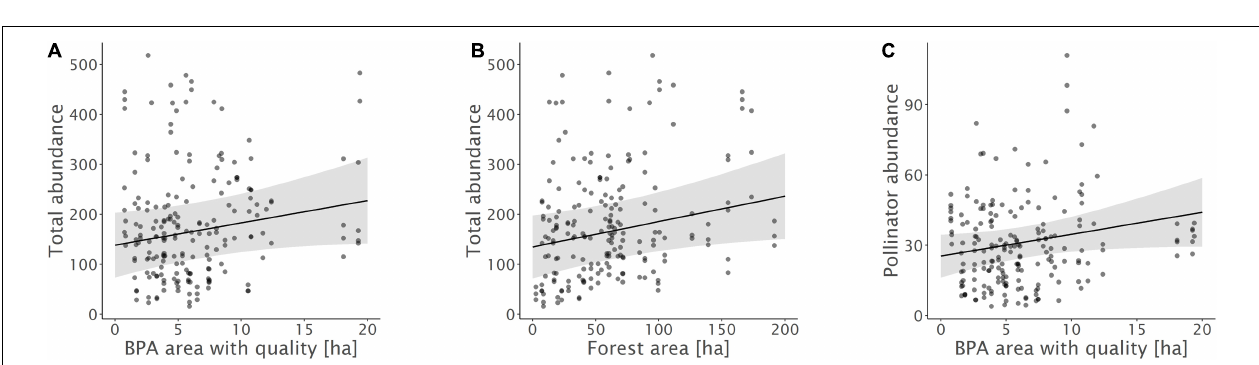
FIGURE 2 | Relationships between (A) total insect abundance, (B) pollinator abundance, (C) natural enemy abundance, (D) wild bee abundance, (E) wild bee species richness, (F) wild bee diversity and the total area of biodiversity promotion areas (BPA) in the 1 km radius landscape circles. Model predictions with 95% confidence intervals and raw data points are